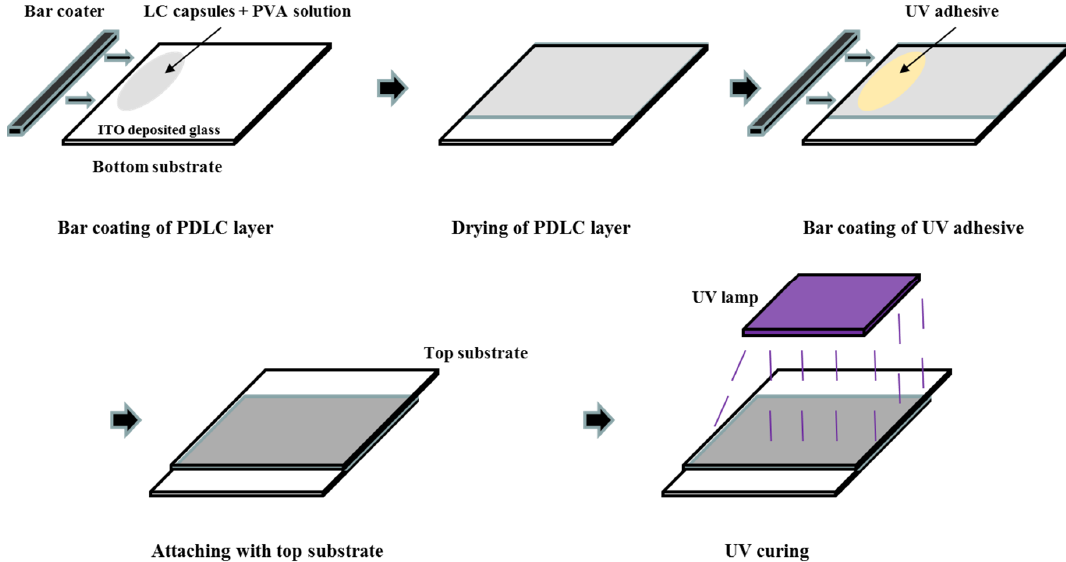
Figure 4. Fabrication process of the polymer-dispersed liquid crystals (PDLCs) device. Indium tin oxide (ITO)-deposited glass is used as the top and bottom substrates. To clean the substrate, de-ionized water, acetone, and isopropyl alcohol (IPA) are used. After the cleaning process, a coating of the mixture of the liquid crystal capsules and polyvinyl alcohol (PVA) solution is applied by a bar coater (Gist). Polyvinyl alcohol (PVA205, Curaray), which has a refractive index of 1.51, is used as the polymer binder. The coated layer is dried at room temperature. After drying of the PDLC layer, the top substrate is bonded to the bottom substrate using UV adhesive with a thickness of 1 µm. By curing the device with UV light, the PDLC device is fabricated.